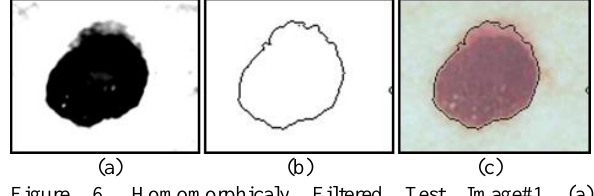
Figure 6. Homomorphicaly Filtered Test Image#1 (a) Photocopy filter (Det: 24, dark:10) (b) Trace Cont. (Level, Edge Lower:170) (c) overlay with original image